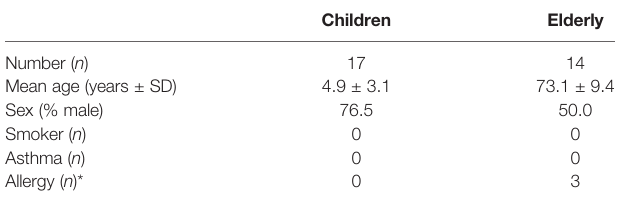
TABLE 1 | Demographics of the study